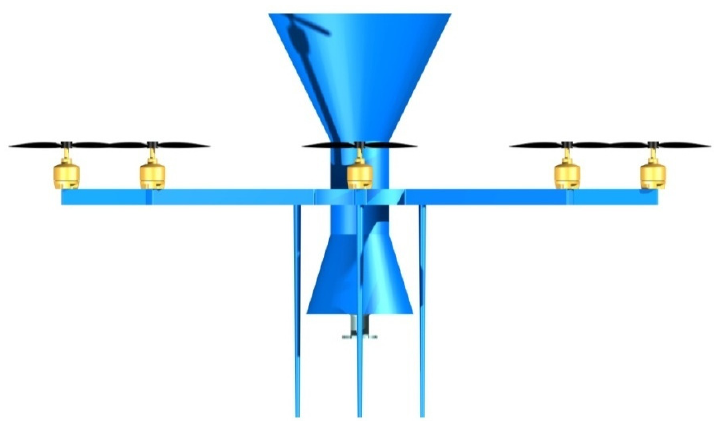
Figure 6. Typical front view of conceptual design of an octocopter.